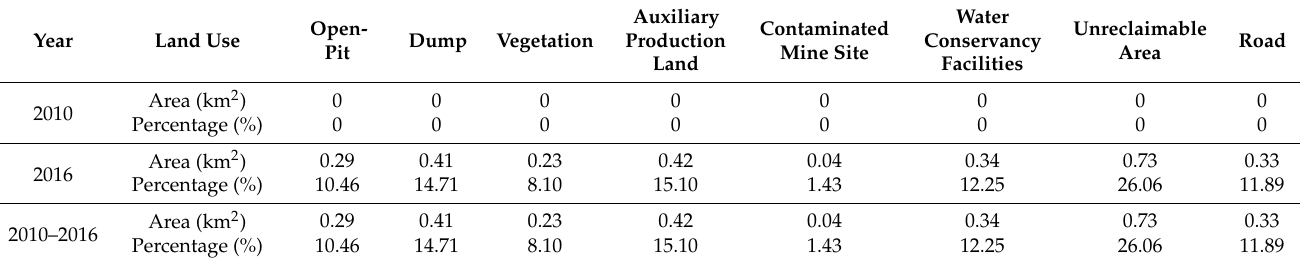
Table 4. Changes in the characteristic surface types of Taldybulak Levoberezhny from 2010 to 2016.